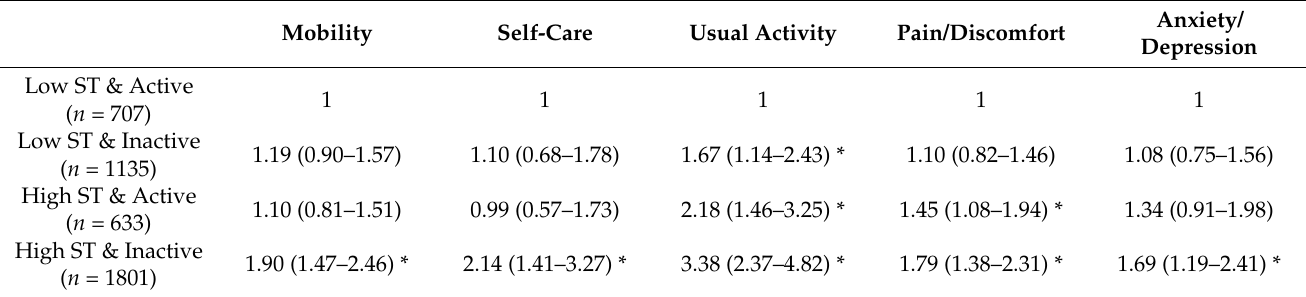
Table 4. Combined association of sitting time and physical activity with each EQ-5D dimension. Mobility Self-Care Usual Activity Pain/Discomfort